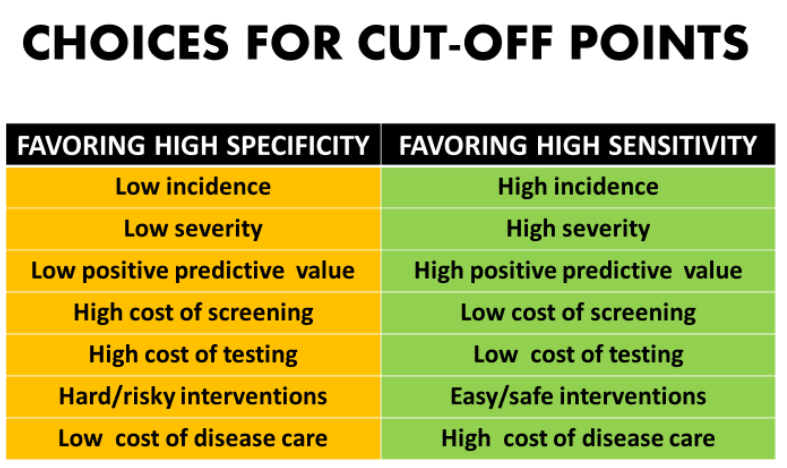
Figure 2. Choices for cut-off points.